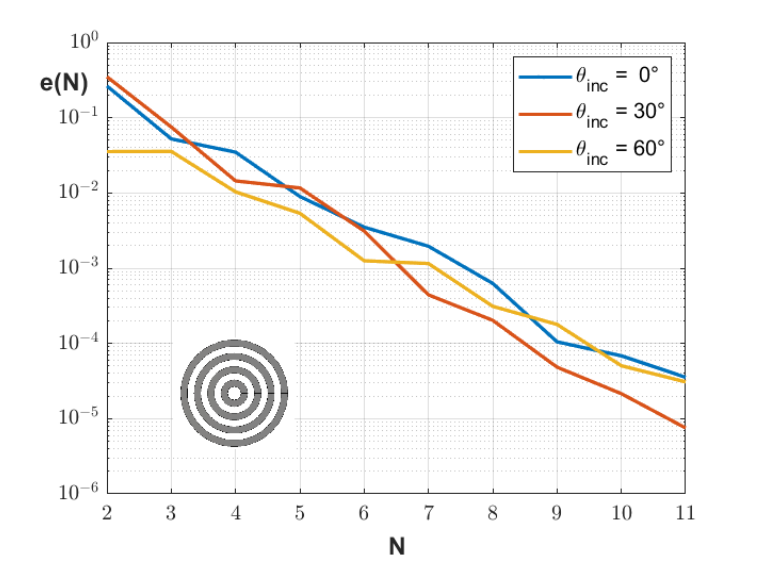
Figure 4. Plot of the error for the geometry #2 of Table 1 (sketched in the inset) for TM incidence and different incidence angles θ inc .